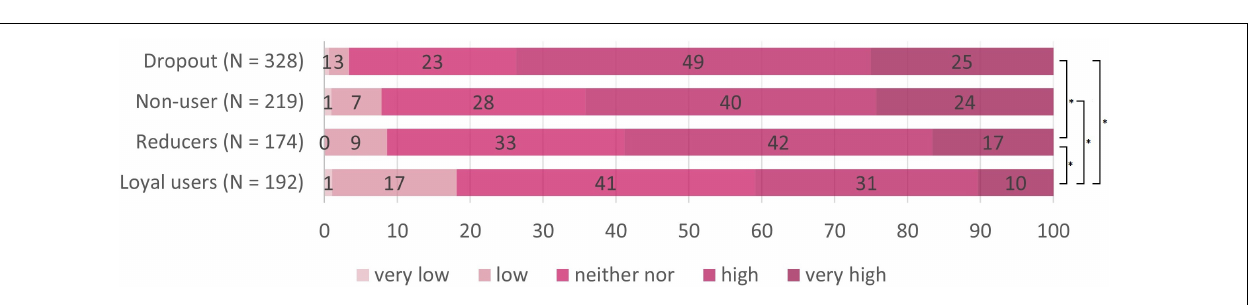
FIGURE 6 | Subjective risk perception for using the bus in the different target groups. N = 918; numbers on the bars represent percentages. * p < 0.008 in the pairwise comparisons.